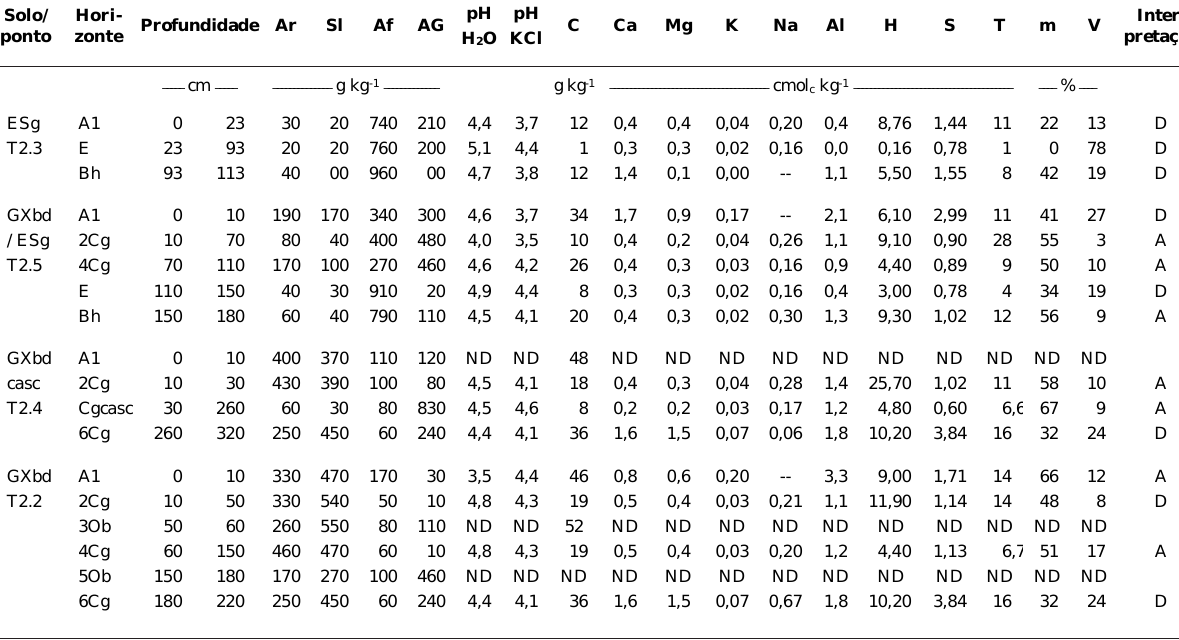
Quadro 2. Resultados analíticos dos perfis da toposseqüência 2 espodossolo/gleissolo (podzol/glei